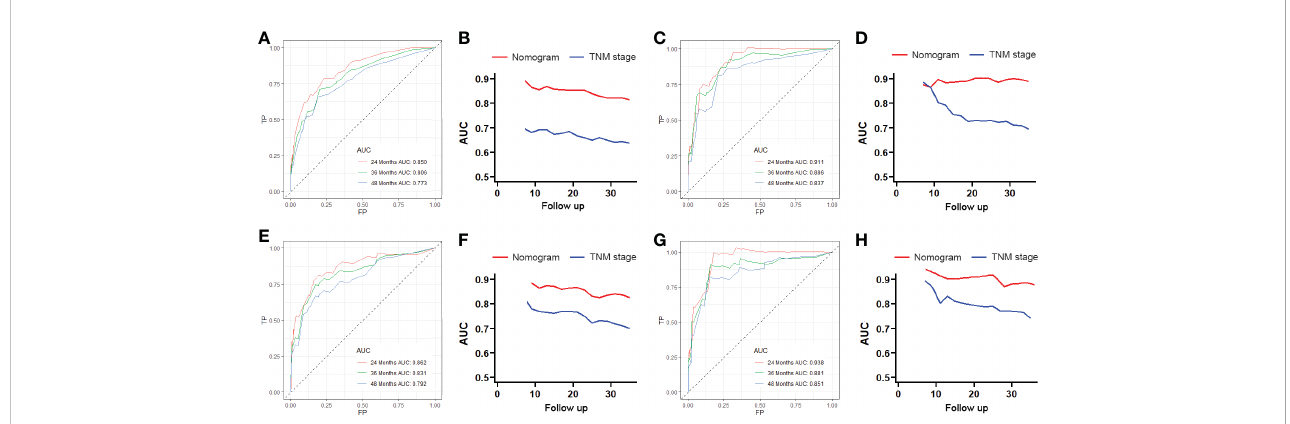
FIGURE 4 The receiving operator characteristic (ROC) curves for 24-, 36-, and 48-month OS in the training cohort (A) and veri fi cation cohort (B) . Comparison of time-dependent ROC curves between the American Joint Committee on Cancer (AJCC) TNM staging system and the nomogram in the training cohort (C) and veri fi cation cohort (D) . The ROC curves for 24-, 36-, and 48-month CSS in the training cohort (E) and veri fi cation cohort (F) . Comparison of time-dependent ROC curves between the AJCC TNM staging system and the nomogram in the training cohort (G) and veri fi cation cohort (H)